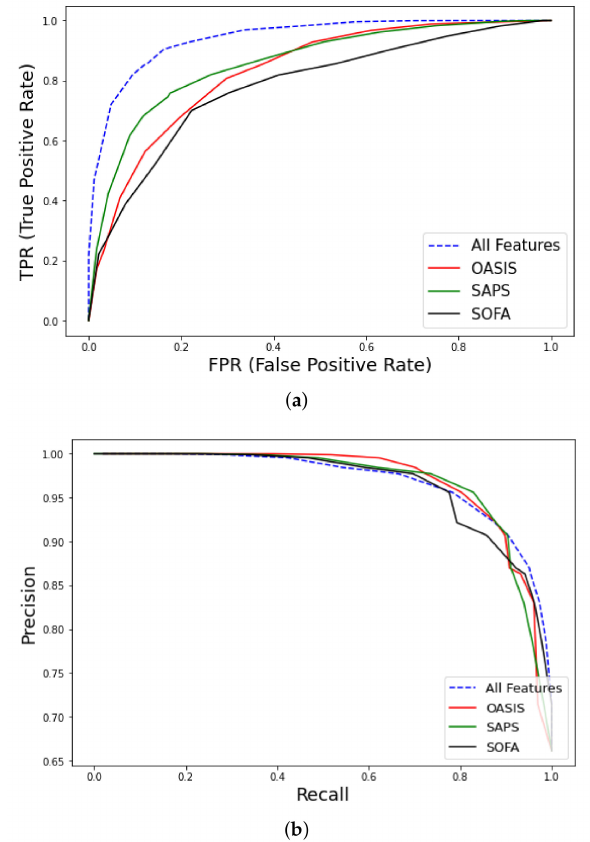
Figure 5. ROC curves for early mortality in ICU patients with cancer from MIMIC-III database using all features. ( a ) AUC – ROC curve and comparison with clinical scores (OASIS, Outcome and Assessment Information Set; SAPS, Simplified Acute Physiology Score; SOFA, Sequential Organ Failure), ( b ) Precision-Recall